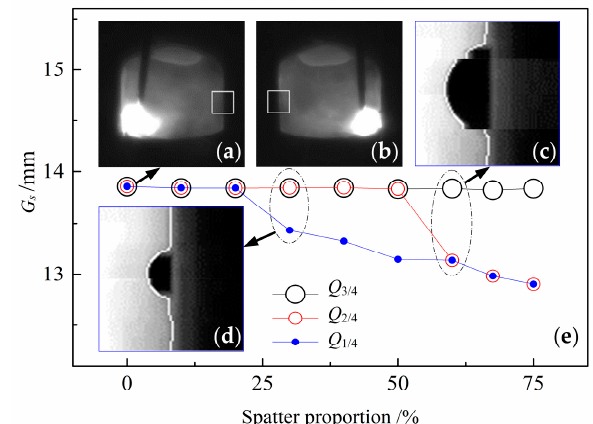
Figure 6. Effect of spatter size proportion and cluster selection threshold Q on sampled value G s of groove width: ( a ) example of welding image for arc at left; ( b ) example of welding image for arc at right; ( c ) simulated spatter of size proportion 60%; ( d ) simulated spatter of size proportion 30%; ( e ) G s at various Q and spatter